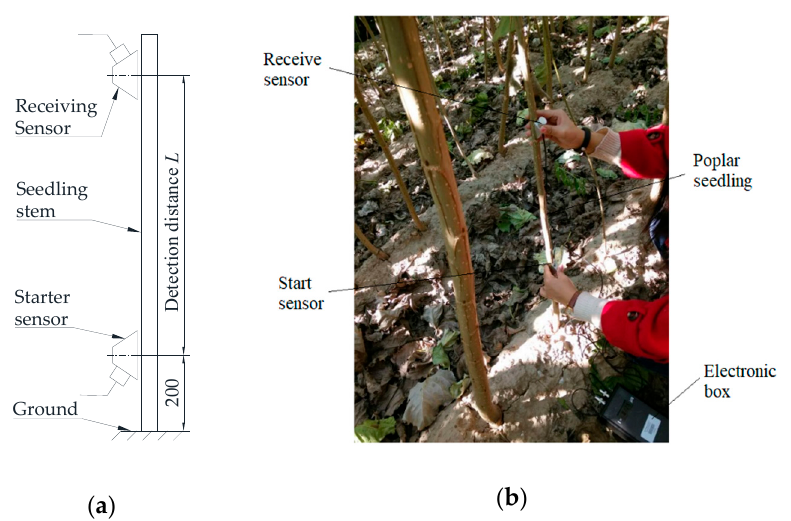
Figure 3. Ultrasonic propagation time measuring method: ( a ) Schematic diagram, ( b ) Field tests.